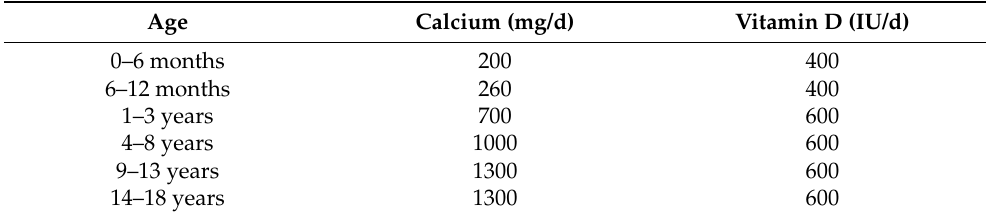
Table 3. Recommended dietary reference intakes (DRI) of calcium and vitamin D (modified from